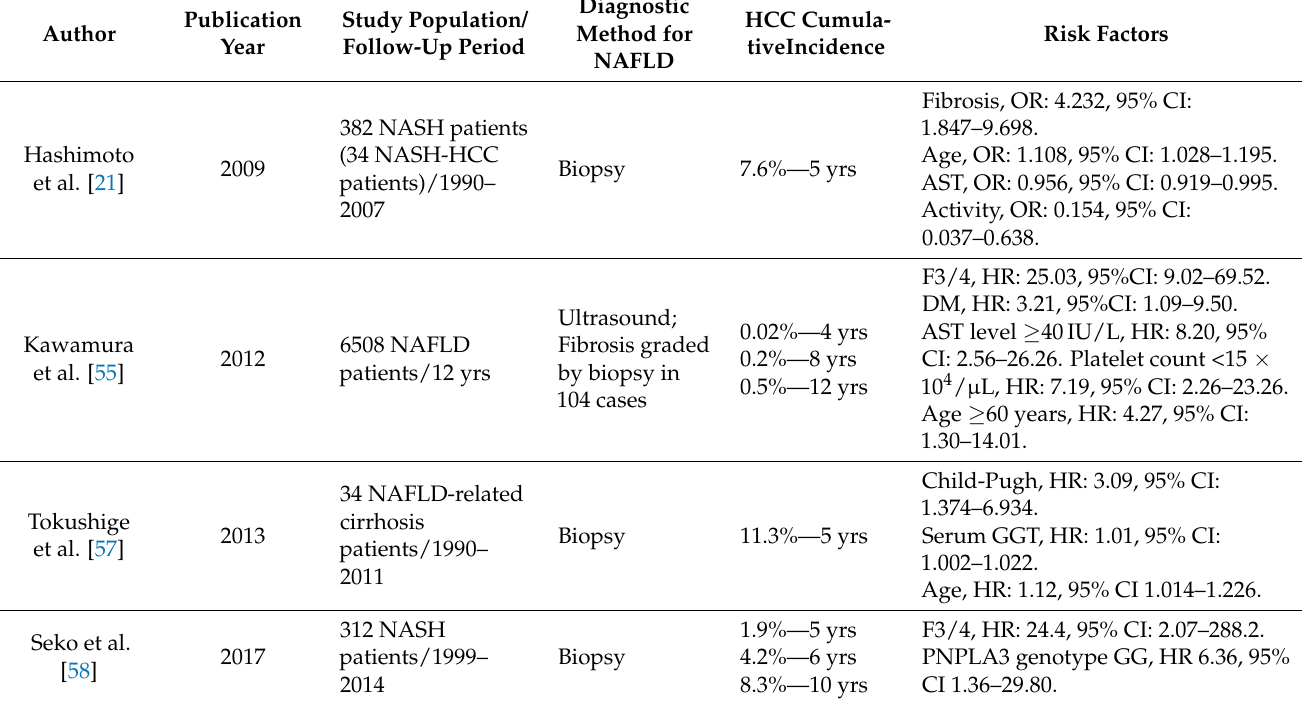
Table 3. Summary of NAFLD-HCC